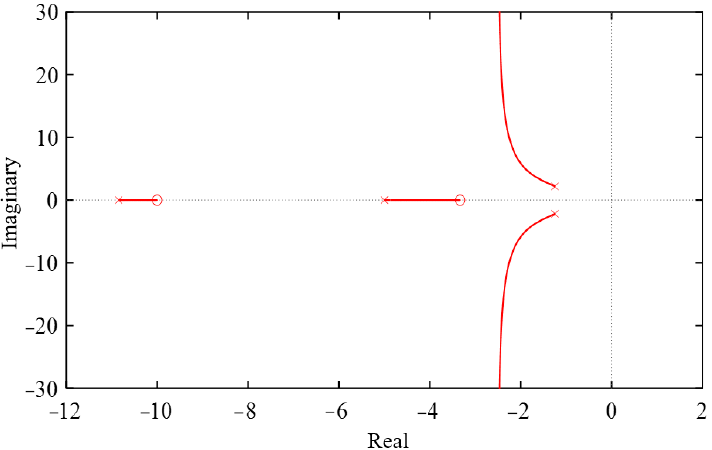
Figure 7. Root locus of (16).